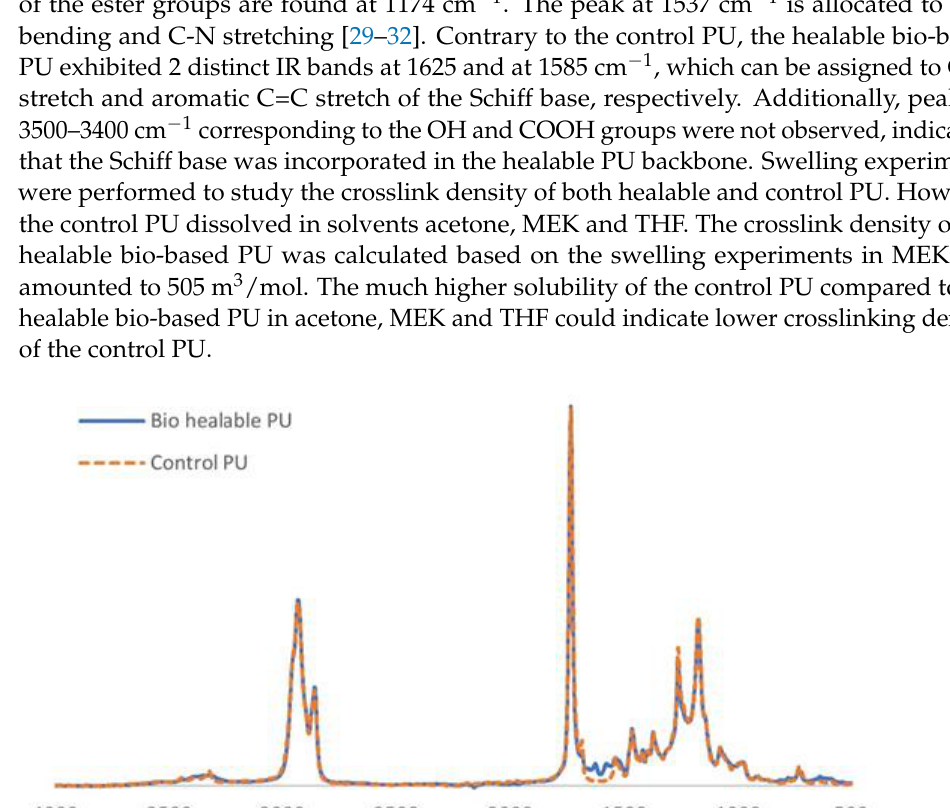
Figure 2. Images taken during scratch healing tests of healable PU ( A ) and control PU ( B ) coated textile after 0 and 30 min at 90 °C. To confirm these results scratch healing was assessed by SEM analysis. Figure 3 shows SEM images of scratched surfaces of healable and control PU before and after heal- ing. As indicated by microscopic images, both PU coatings showed narrowing of the scratch, but only in the case of the healable PU the scratch was closed and healed. Indeed, PUs possess dynamic hydrogen bonds between urethane moieties, resulting in the nar- rowing of the scratch, even in the absence of additional functional groups, but not